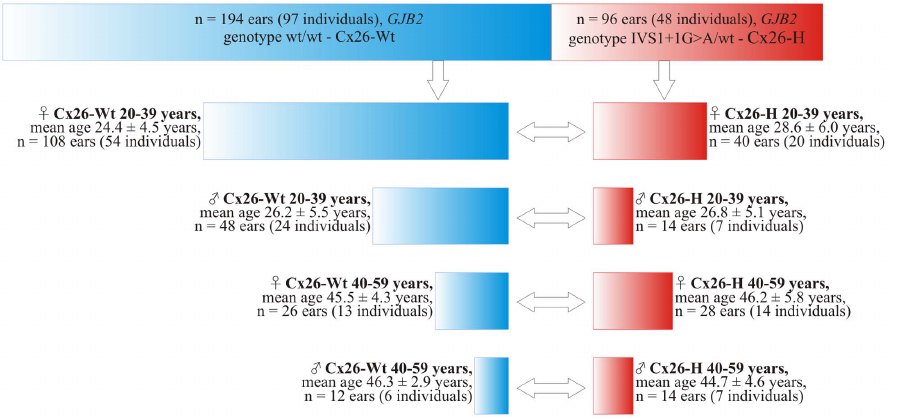
Figure 1. Design of Cx26-H and Cx26-Wt groups. Note: Cx26-Wt (IVS1 + 1G . A non-carriers) is shown in blue, Cx26-H (IVS1 + 1G . A carriers) is shown in red; bilateral arrows show the compared subgroups; R – female, = – male.